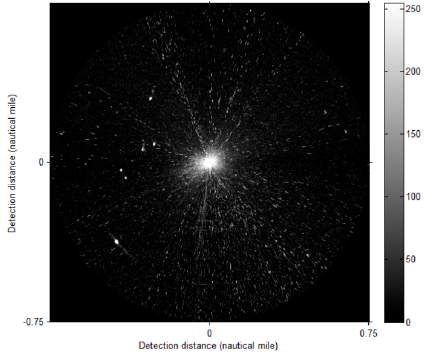
Figure 18. Sea clutter image of calm sea surface.